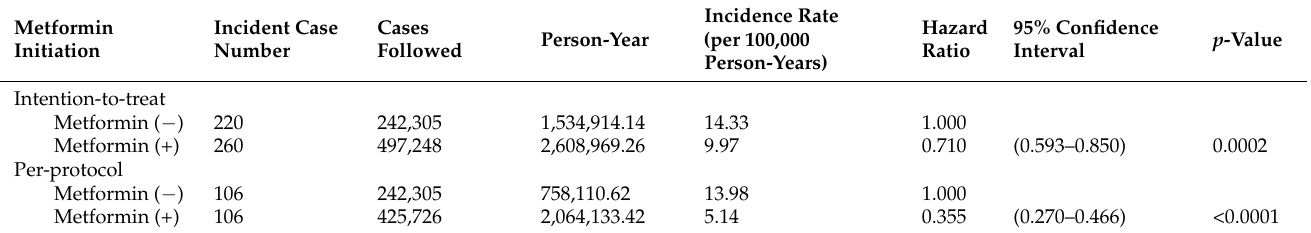
Table 2. Incidence of multiple myeloma and hazard ratios comparing metformin initiators (metformin